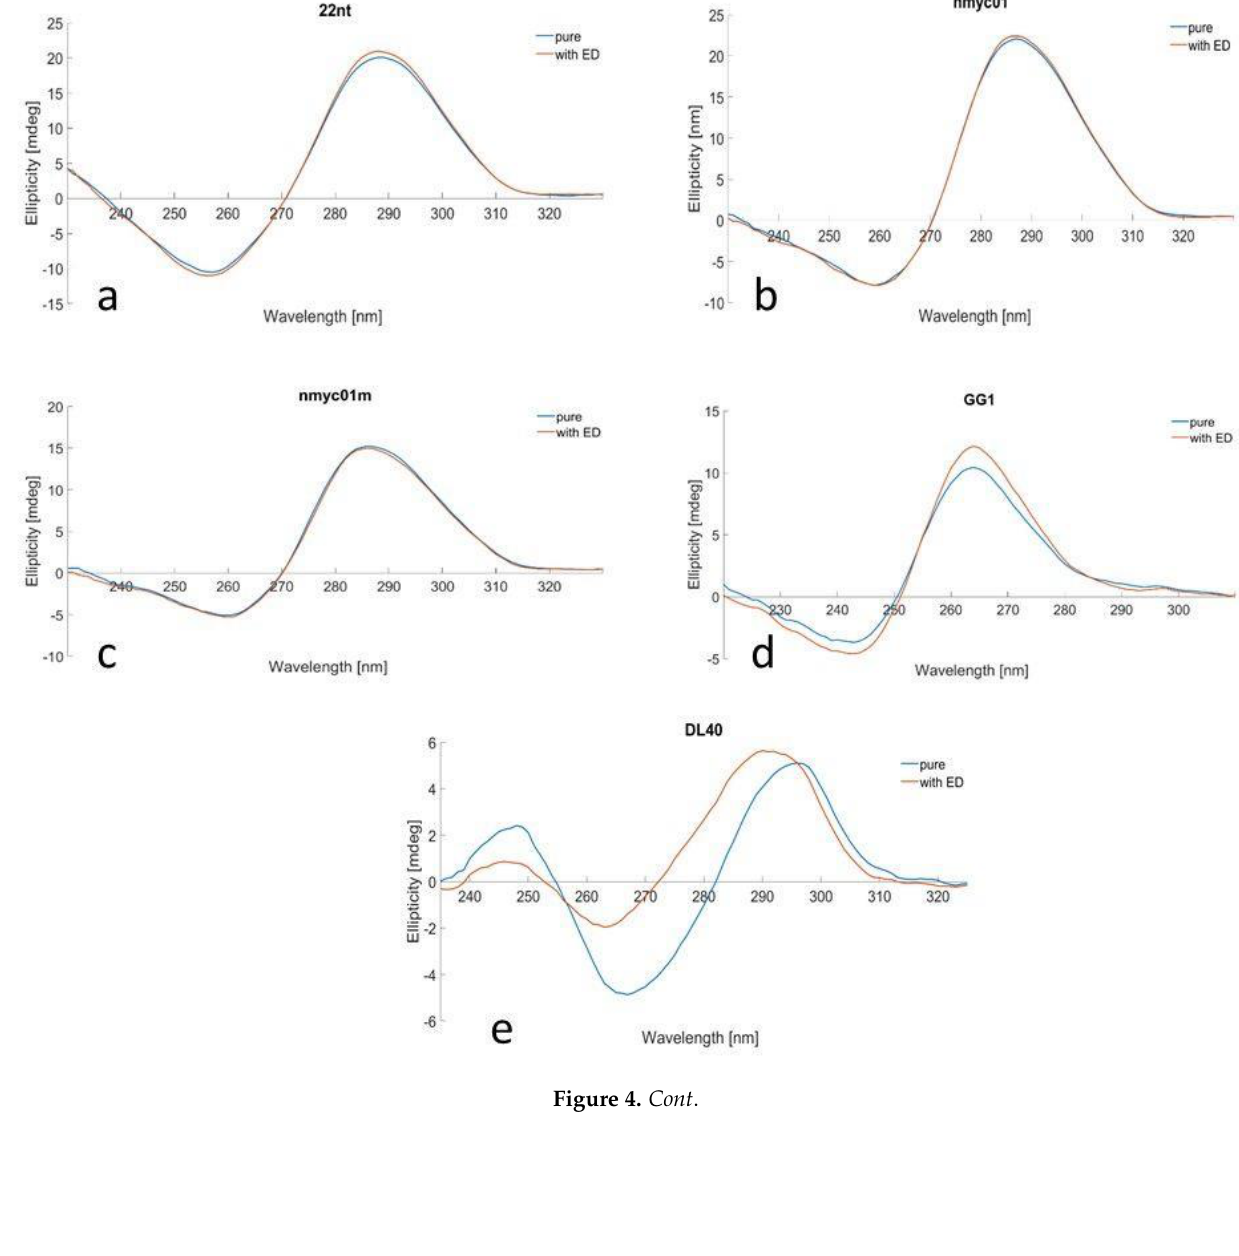
Figure 4. pH 5: CD spectra of 22nt ( a ), nmyc01 ( b ), and nmyc01m ( c ) in the absence (blue) and pres- ence (red) of escholidine in acetic buffer (c oligo = 2 µM, t = 20 °C). pH 7: CD spectra of GG1 ( d ), and DL40 ( e ), in the absence (blue) and presence (red) of escholidine at phosphate buffer (coligo = 2 µM, t = 20 °C). Temperature dependence: CD spectra recorded along with the melting experiment of